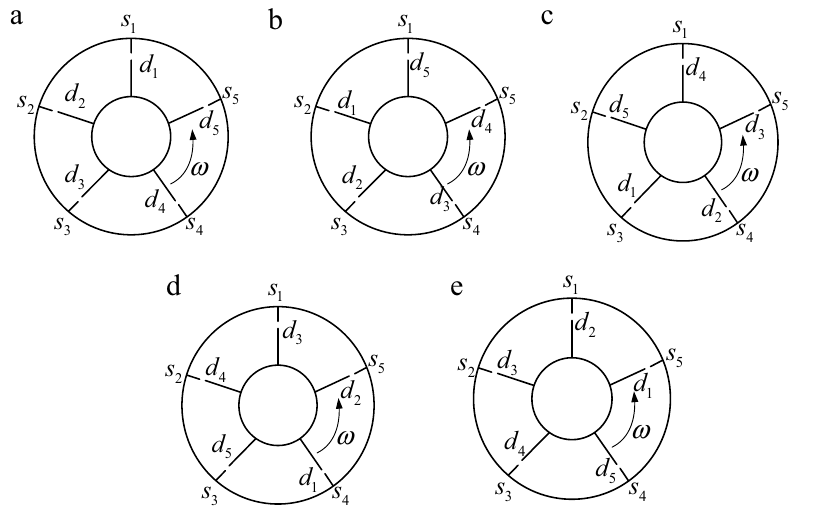
Figure 10. The position relationship of moving and stationary blades during one rotation cycle. ( a ) 0/5 cycle. ( b ) 1/5 cycle. ( c ) 2/5 cycle. ( d ) 3/5 cycle. ( e ) 4/5